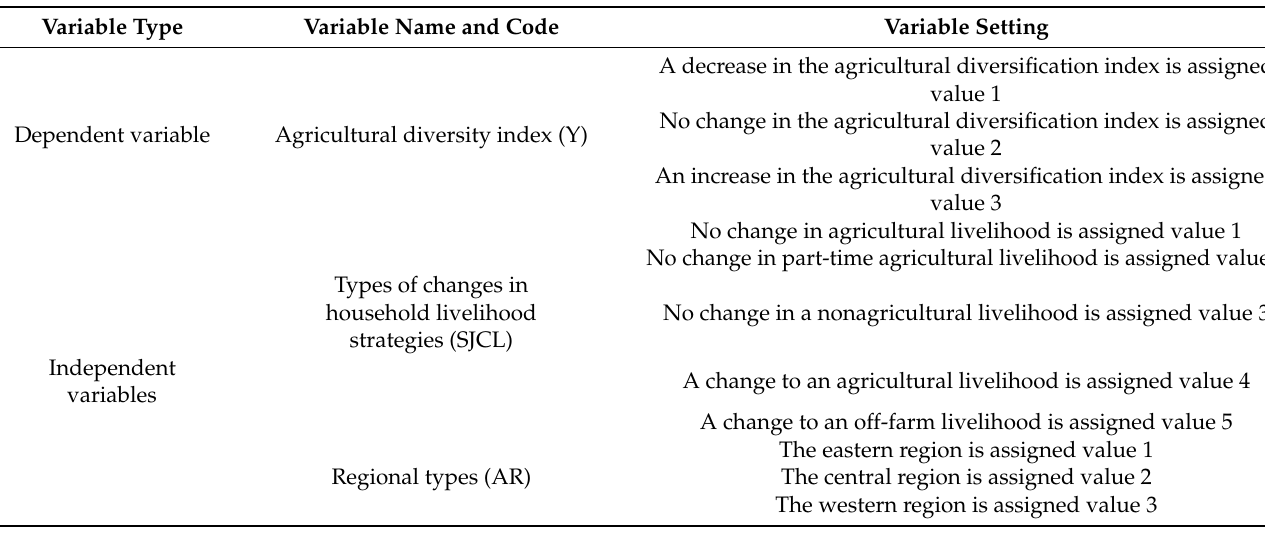
Table 2. Variable definitions and